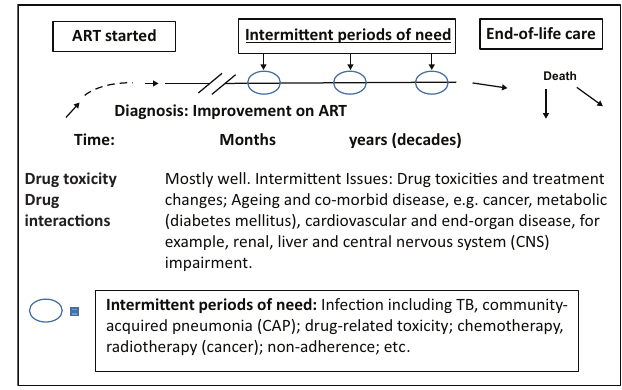
FIGURE 3: The HIV-infected patient, no palliative care.